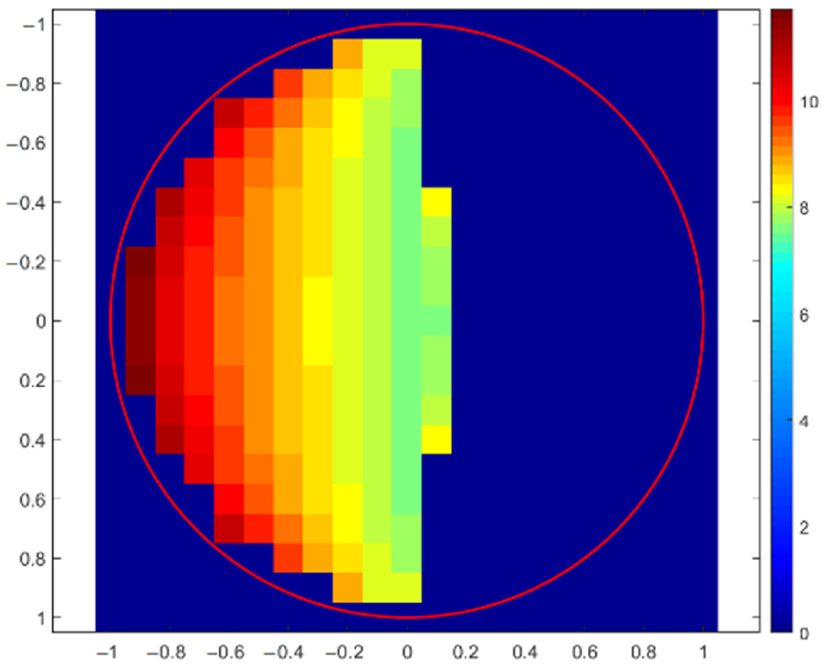
Figure 10. Copper concentration map of sterling silver sphere-shaped hole determined with Monte Carlo simulation of XRF scanning applying Cu-K α and Ag-K α lines. The correct Cu concentration was 7.5%.